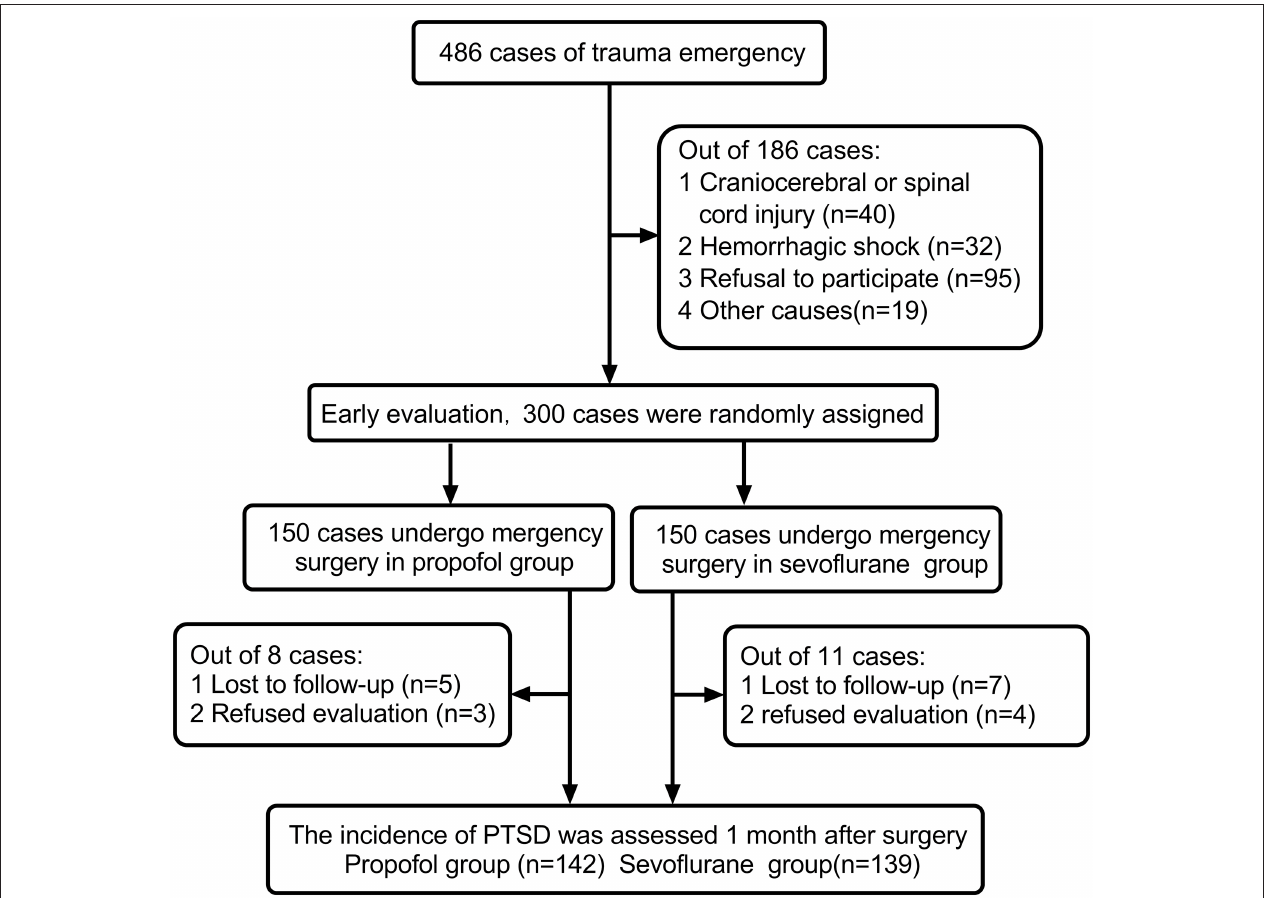
FIGURE 1 | Enrollment flowchart for patients in this